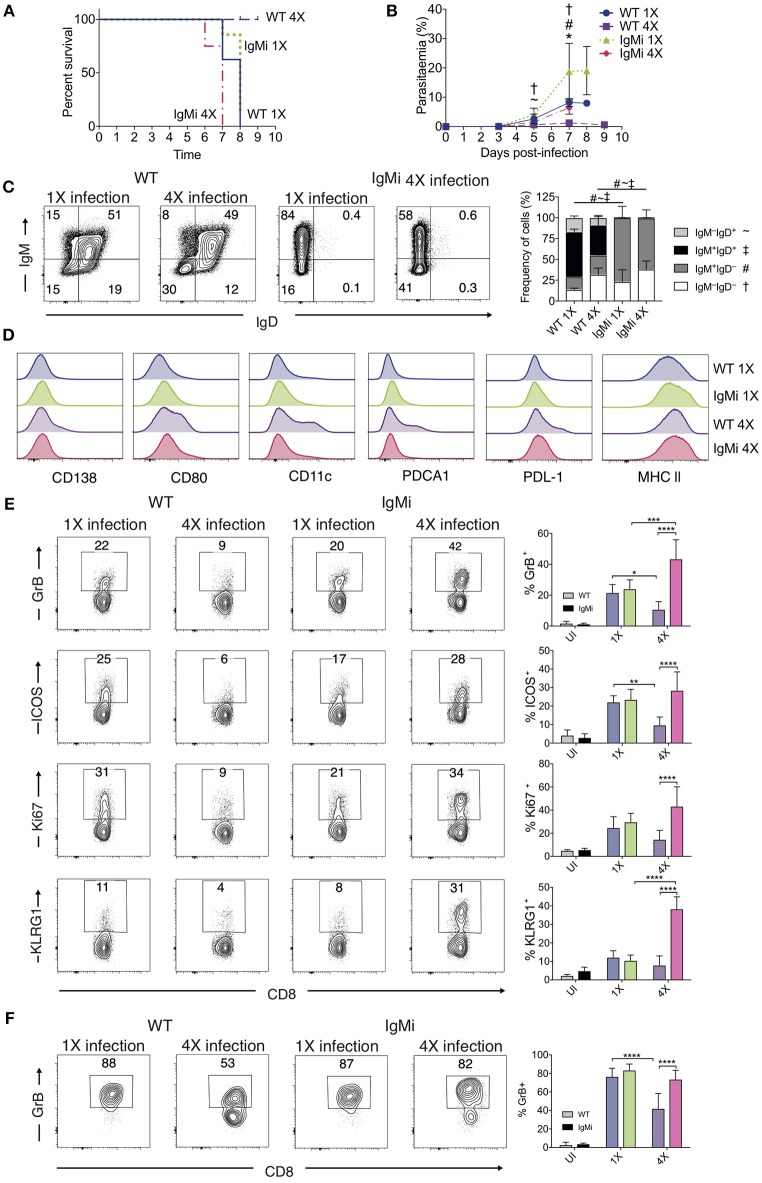
IgMi mice do not develop infection-induced resistance to ECM. (A–F) IgMi mice and WT littermate controls were infected with PbA (104 pRBCs i.v.) or left uninfected. Mice were treated (i.p.) with chloroquine and artesunate from day 5 or 6 post each infection, and re-infections were performed after a minimum interval of 30 days following cessation of drug treatment. (A) Kinetics of ECM development, shown as percentage of survival of mice. (B) Peripheral parasitaemia (% of pRBCs). (C) Left, Representative flow cytometric plots (gated on live CD45+CD3−CD19+ cells), right, the frequencies of non-switched (IgM+IgD+ and IgM−IgD+) and switched (IgM+IgD−, and IgM−IgD−) splenic CD19+ B cells. (D) Expression of CD138, CD80, CD11c, PDCA1, PDL-1 and MHC II by CD19+ splenic B cells from 1X infected and 4X infected WT and IgMi mice. (E,F) Activation phenotype of (E) splenic and (F) brain accumulating CD8+ T cells. (B,C,E,F) Results are the mean ± SD of the group. (A,B)
N = 7–8 per group, pooled from two independent experiments. (C)
N = 3–4 per group, representative of two independent experiments. (E,F)
N = 5–8 per group, pooled from two independent experiments. (B,E,F) Statistical analyses were performed with Kruskal-Wallis test with Dunn's multiple comparisons test or with one-way ANOVA with Tukey's test depending on normality of data (*p ≤ 0.05, **p ≤ 0.01, ***p ≤ 0.001, ****p ≤ 0.0001, and p < 0.05 denoted as follows *, WT 1X v IgMi 1X, ~, WT 4X v IgMi 1X, #, WT 4X v IgMi 4X, †, IgMi 1X v IgMi 4X). (C) Statistical analysis by Student's t-test, with Welch's correction for indicated groups (p < 0.05 denoted by #, ~, ‡ for the indicated groups).